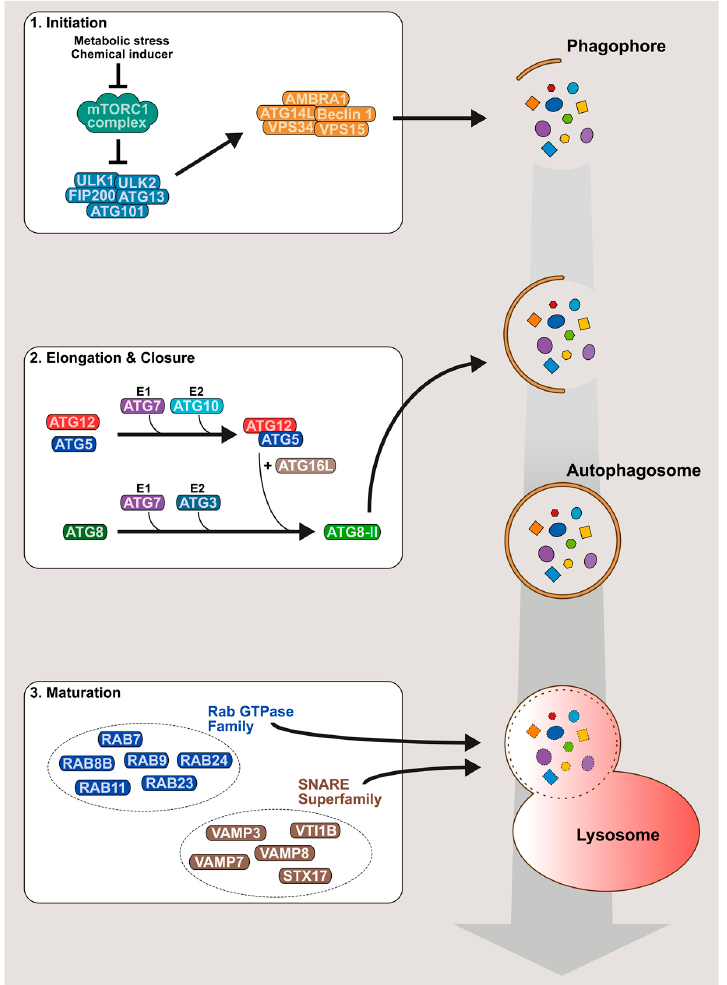
Figure 1. Schematic model of canonical autophagy. Canonical autophagy, which induces formation of double-layered membrane vesicles (autophagosomes) sequestrating cytoplasmic material, can be divided into three main stages: (1) initiation, (2) elongation and closure, and (3) maturation. Briefly, in the absence of pro-autophagy signals, mTORC1 complex maintains the preinitiation complex of autophagy (ULK1, ULK2, FIP200, ATG101 and ATG13) in an inactivated state by phosphorylating ULK1 and ATG13. Upon autophagy stimulation (metabolic stress or chemical inducers), mTORC1 complex is inhibited, allowing the preinitiation complex to activate the PI3K complex (VPS34, VPS15, Beclin 1, ATG14L and AMBRA1). This latter triggers the isolation of a cellular membrane (phagophore) at the endoplasmic reticulum (ER) surface by producing phosphatidylinositol-3-phosphate. Elongation and closure of phagophore are driven by lipidated forms of ATG8 family members. ATG8 orthologs exist in two forms, depending on the autophagy state: a non-lipidated cytosolic form (ATG8; inactive autophagy state) or a lipidated membrane-bound form (ATG8-II; active autophagy state). ATG8 lipidation reaction is controlled by two ubiquitine-like systems composed of the E1-like enzyme ATG7 and E2-like enzymes ATG10 or ATG3. The ATG7/ATG10 system generates the ATG5-ATG12 conjugate which, in interaction with ATG16L, is essential for specifying the site of ATG8-II production at the phagophore membrane. The maturation step, corresponding to the fusion between autophagosomes and lysosomes, is regulated by members of the Rab GTPase family and the SNARE superfamily. This process results in degradation of the autophagosomal content. ULK: UNC-51-like kinase; FIP200: focal adhesion kinase family-interacting protein of 200 kDa; mTORC1: mTOR complex 1; PI3K: phosphatidylinositol 3-kinase; VPS: vacuolar protein sorting proteins; AMBRA1: activating molecule in Beclin 1-related autophagy 1; ATG: autophagy-related proteins; SNARE: soluble N -ethylmaleimide attachment protein receptor.